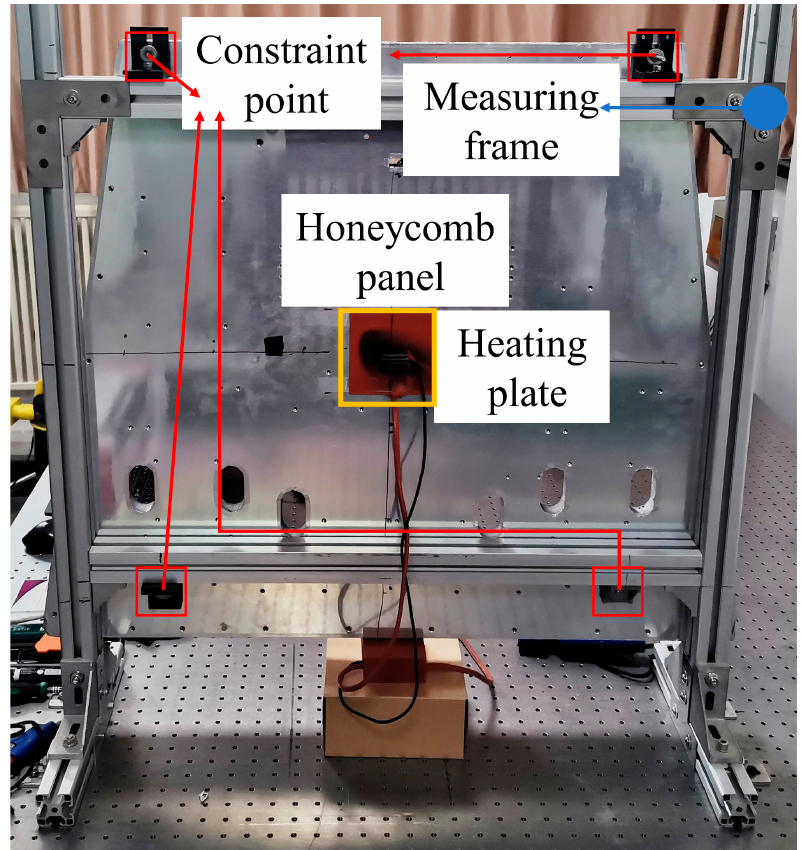
Figure 8. Experimental device diagram.